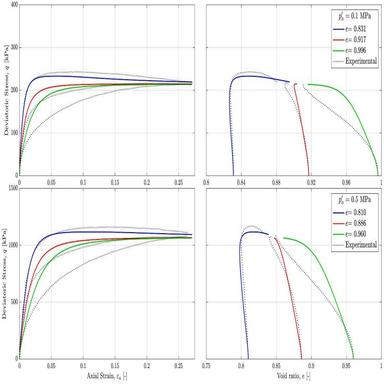
Toyoura sand. Simulations compared with experiments in drained triaxial tests (adapted from Verdugo & Ishihara).